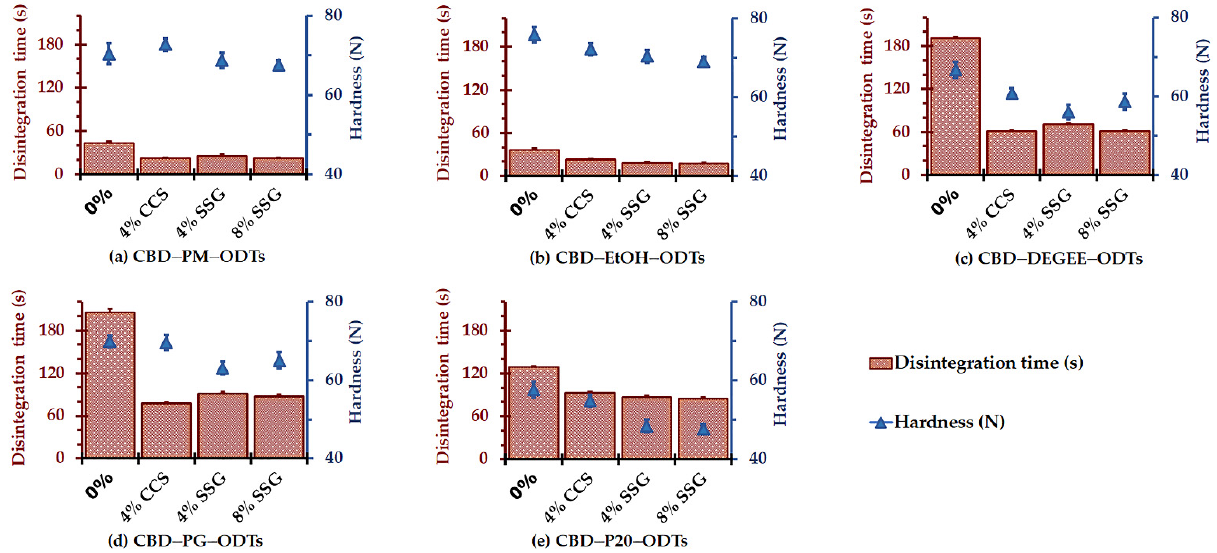
Figure 1. Influence of superdisintegrants on tablet hardness and disintegration time of 4.9-MPa-compressed CBD ODTs (mean ± SD, n = 6).